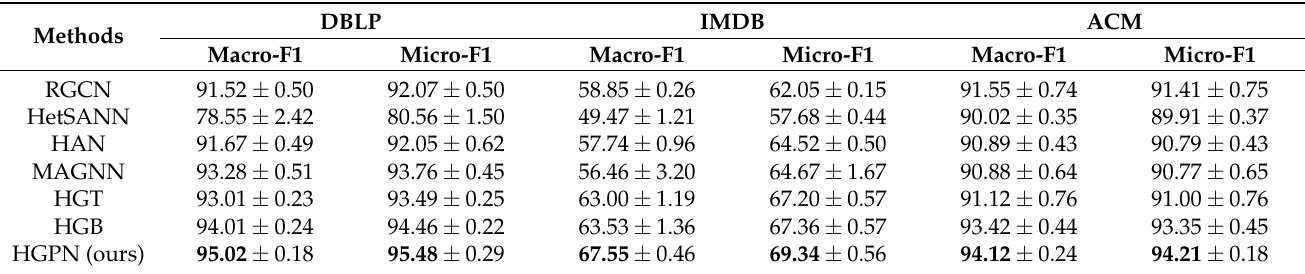
Table 2. Overall performances on ACM, DBLP and IMDB. The numbers in bold mean the best results. All methods are tested 10 times and we report the average